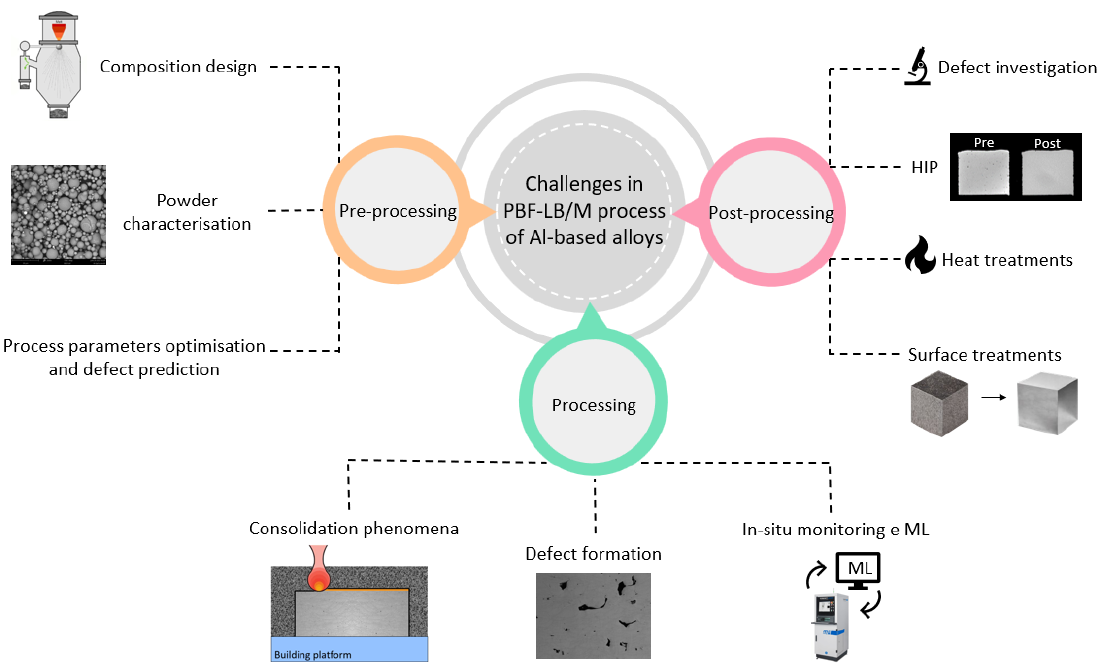
Figure 1. Graphical overview of the review